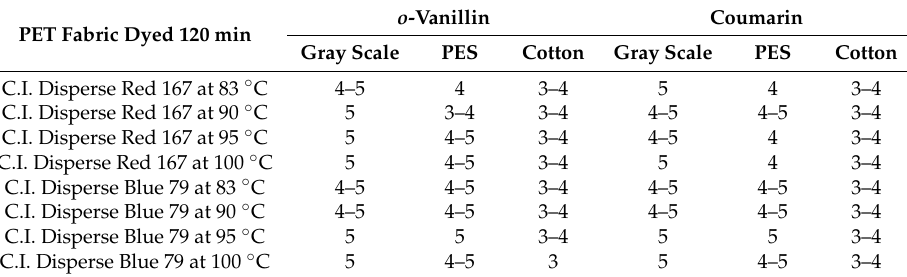
Table 7. Colour fastness by washing of polyester dyed